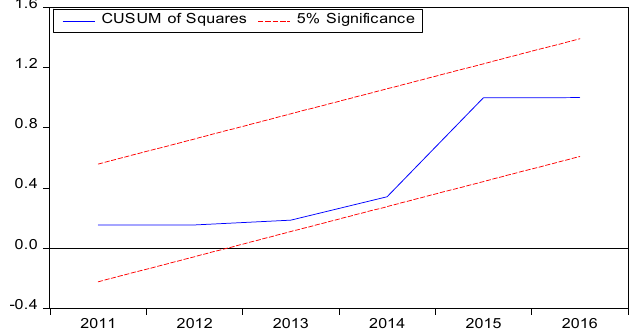
Figure 2. Cumulative sum of Square (CUSUMSQ) test.